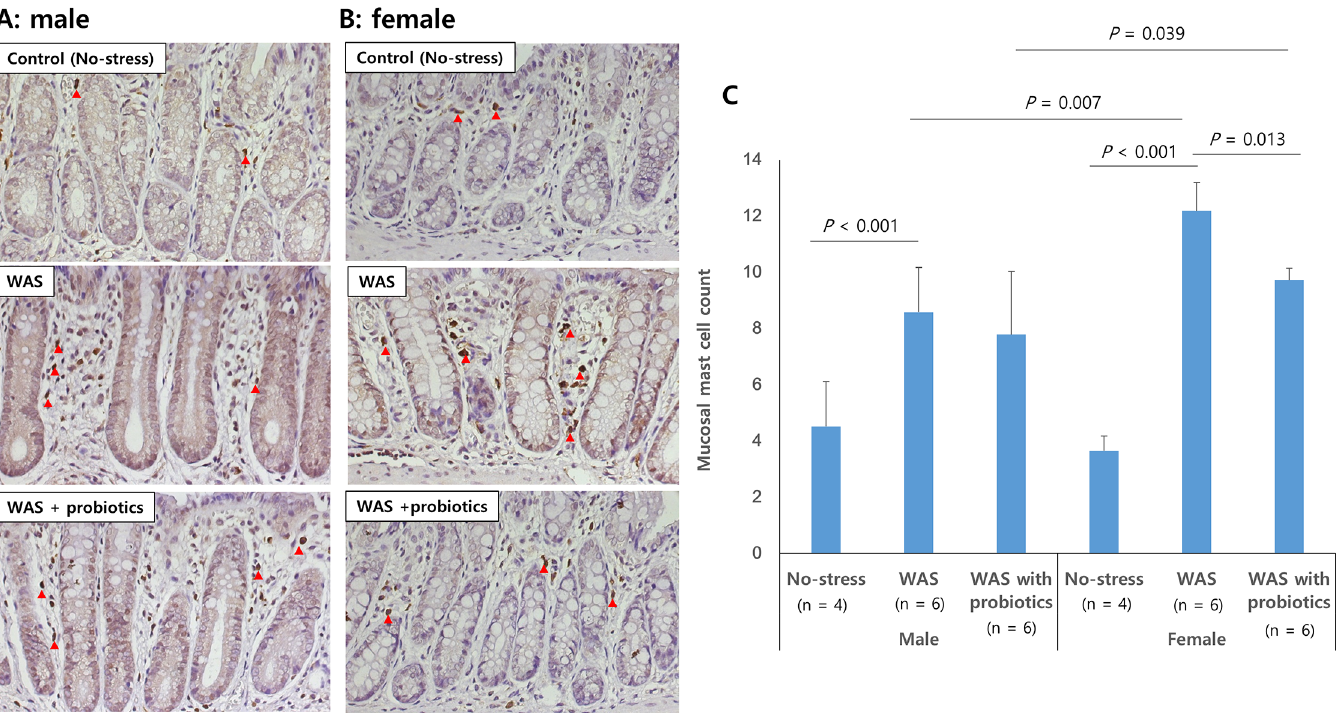
Fig 4. Number of mucosal mast cells detected after anti-mast cell tryptaseantibody staining (A: male, B: female, red arrow, × 400). Mucosal mast cell counts in distal colon were higherin the water avoidancestress (WAS) group than in the no-stress group in both male and female rats. Female WAS with probiotics group showedsignificantly lower mast cell count than female WAS group ( P = 0.013) (C).Data are expressedas means ± SEM.